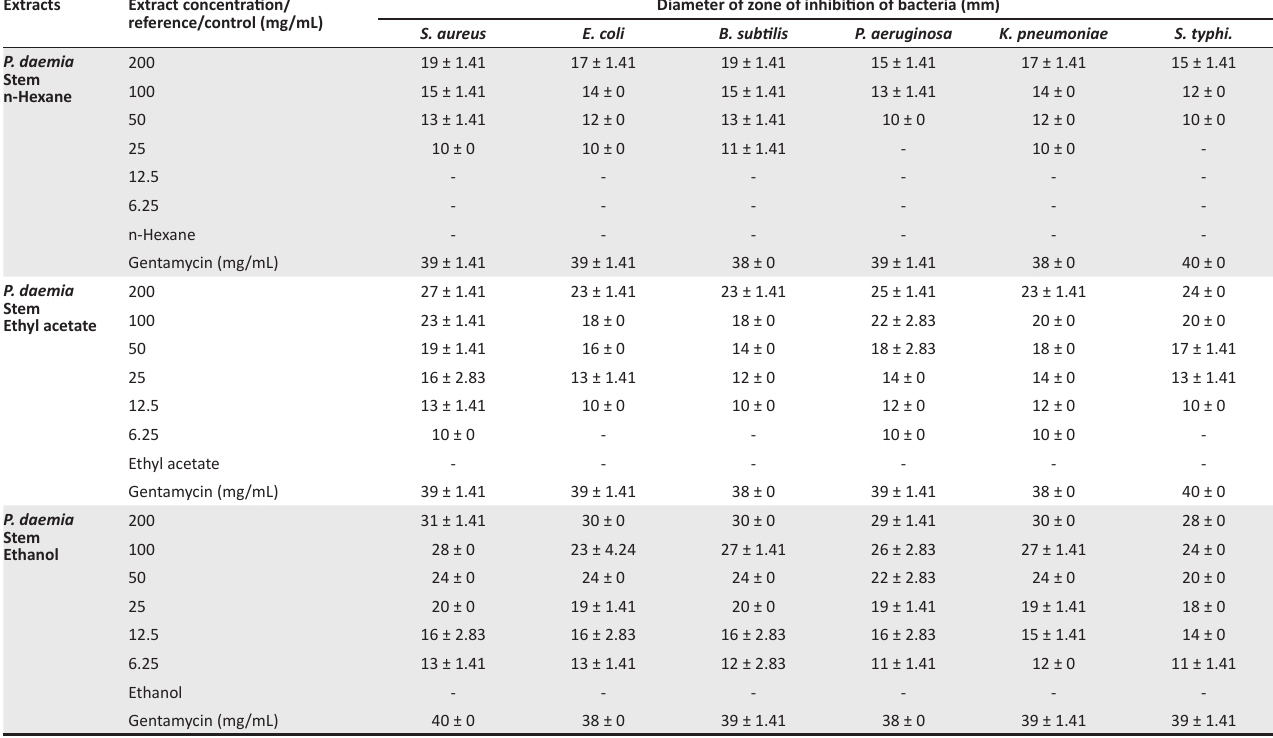
Diameter of zone of inhibition of bacteria (mm)